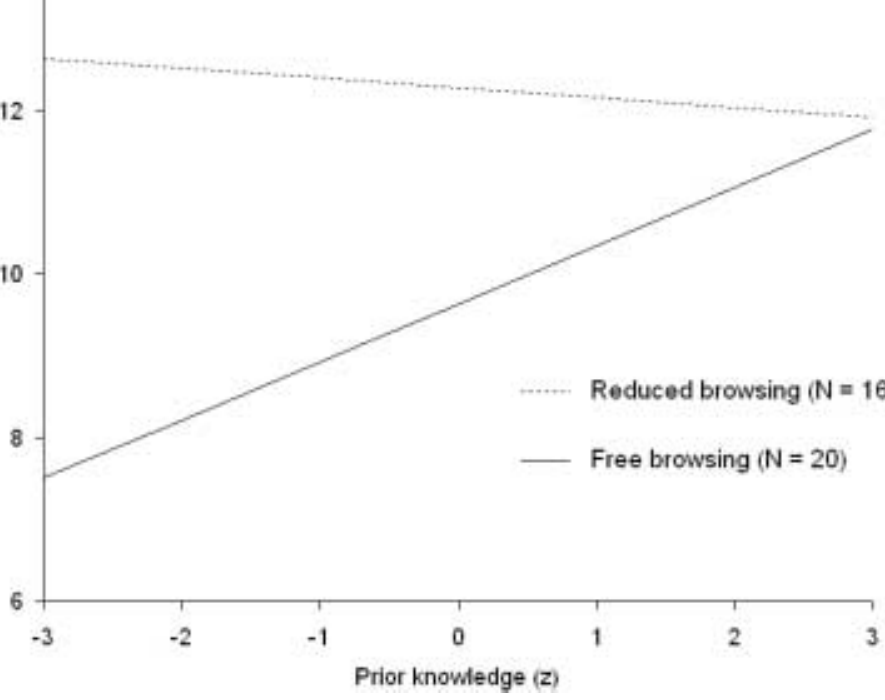
Figure 3. Structural knowledge as a function of the learner variable prior knowledge (linear regression), computed separately for the two experimental